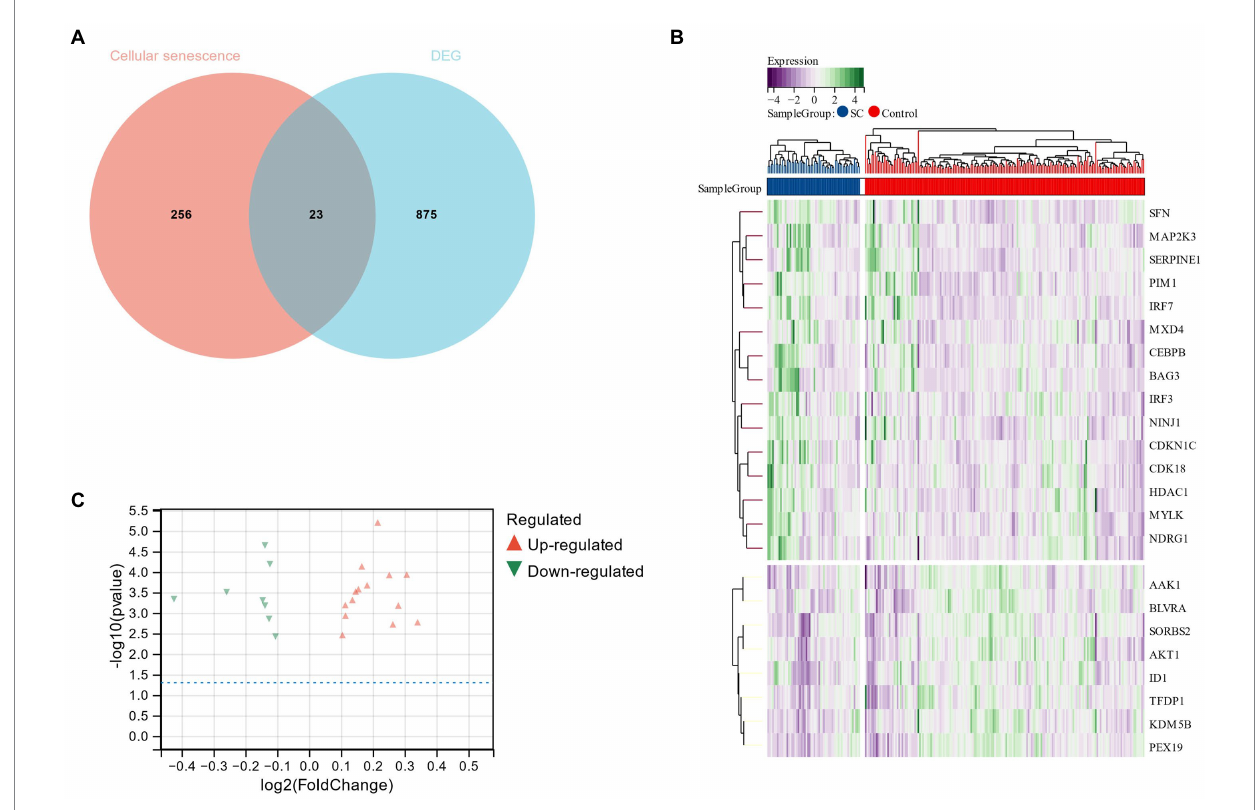
FIGURE 4 (A) Venn diagram for cross-screening of genes related to schizophrenia and cell senescence; (B,C) : Heat map and volcano plot of cell senescence